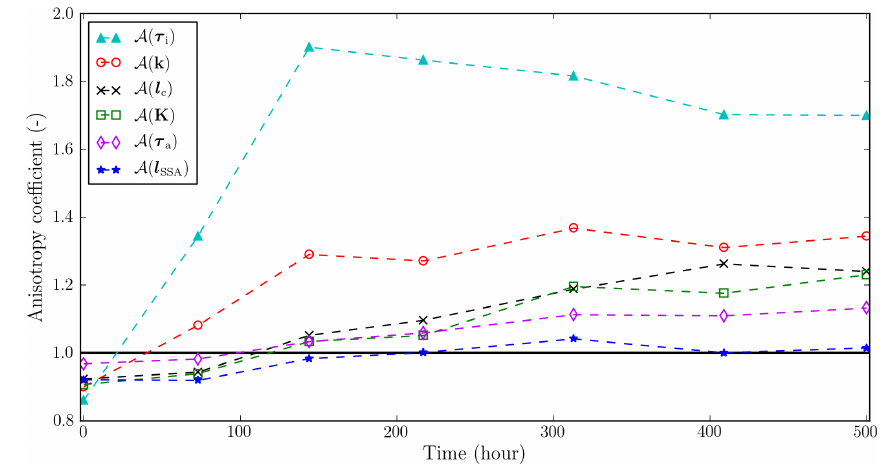
Figure 7. Time evolution of the anisotropy coefficient of the whole computed